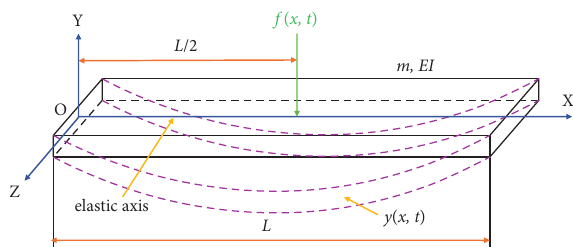
Figure 7: Deformation of support beam under